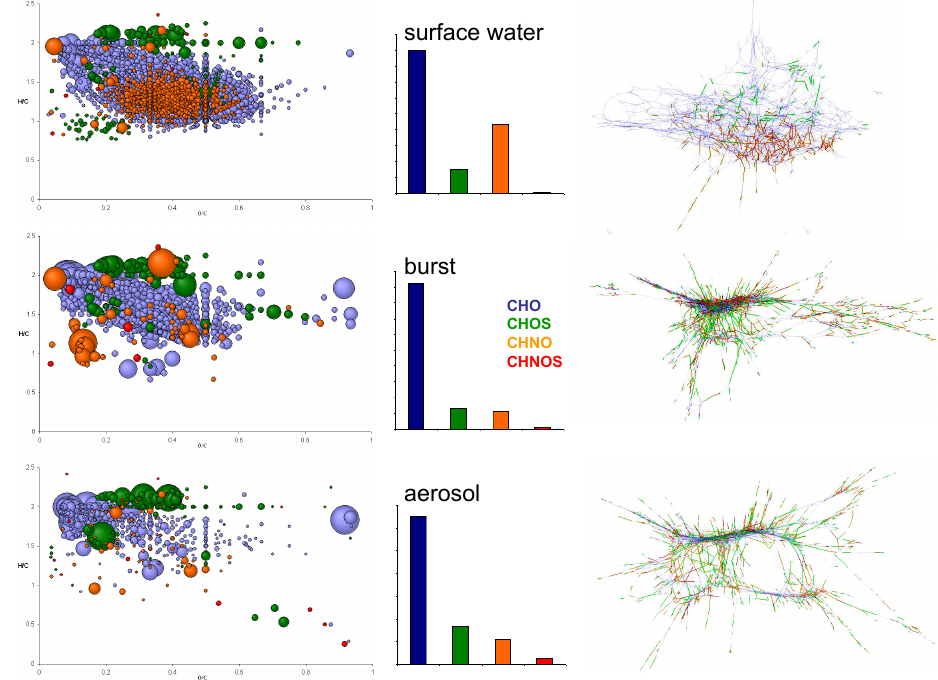
Fig. 5. Sampling day 27 (Angola Basin) represented as van Krevelen diagrams of the surface, burst and day aerosol samples and correspond- ing compositional frequency histograms and corresponding compositional networks (color code as in previous figures).